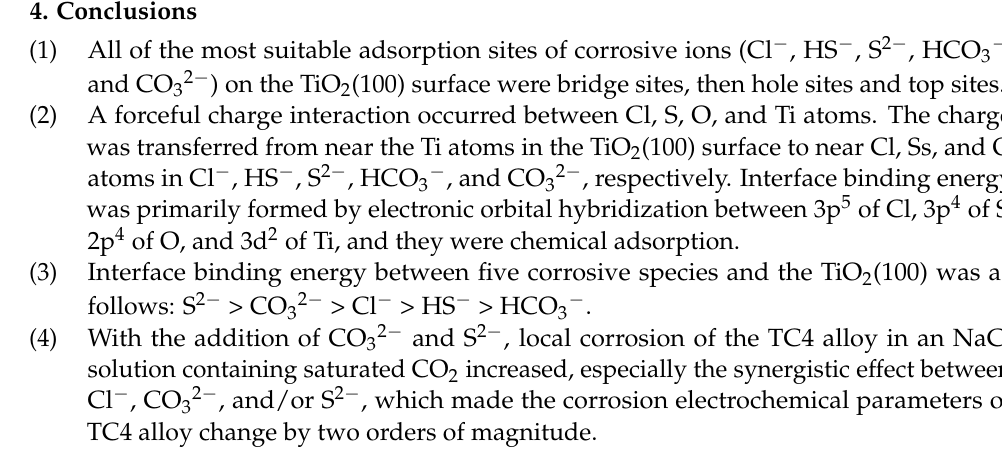
Table 8. Electrochemical parameters of titanium alloy in 35% NaCl + 0.4% Na 2 S [25].